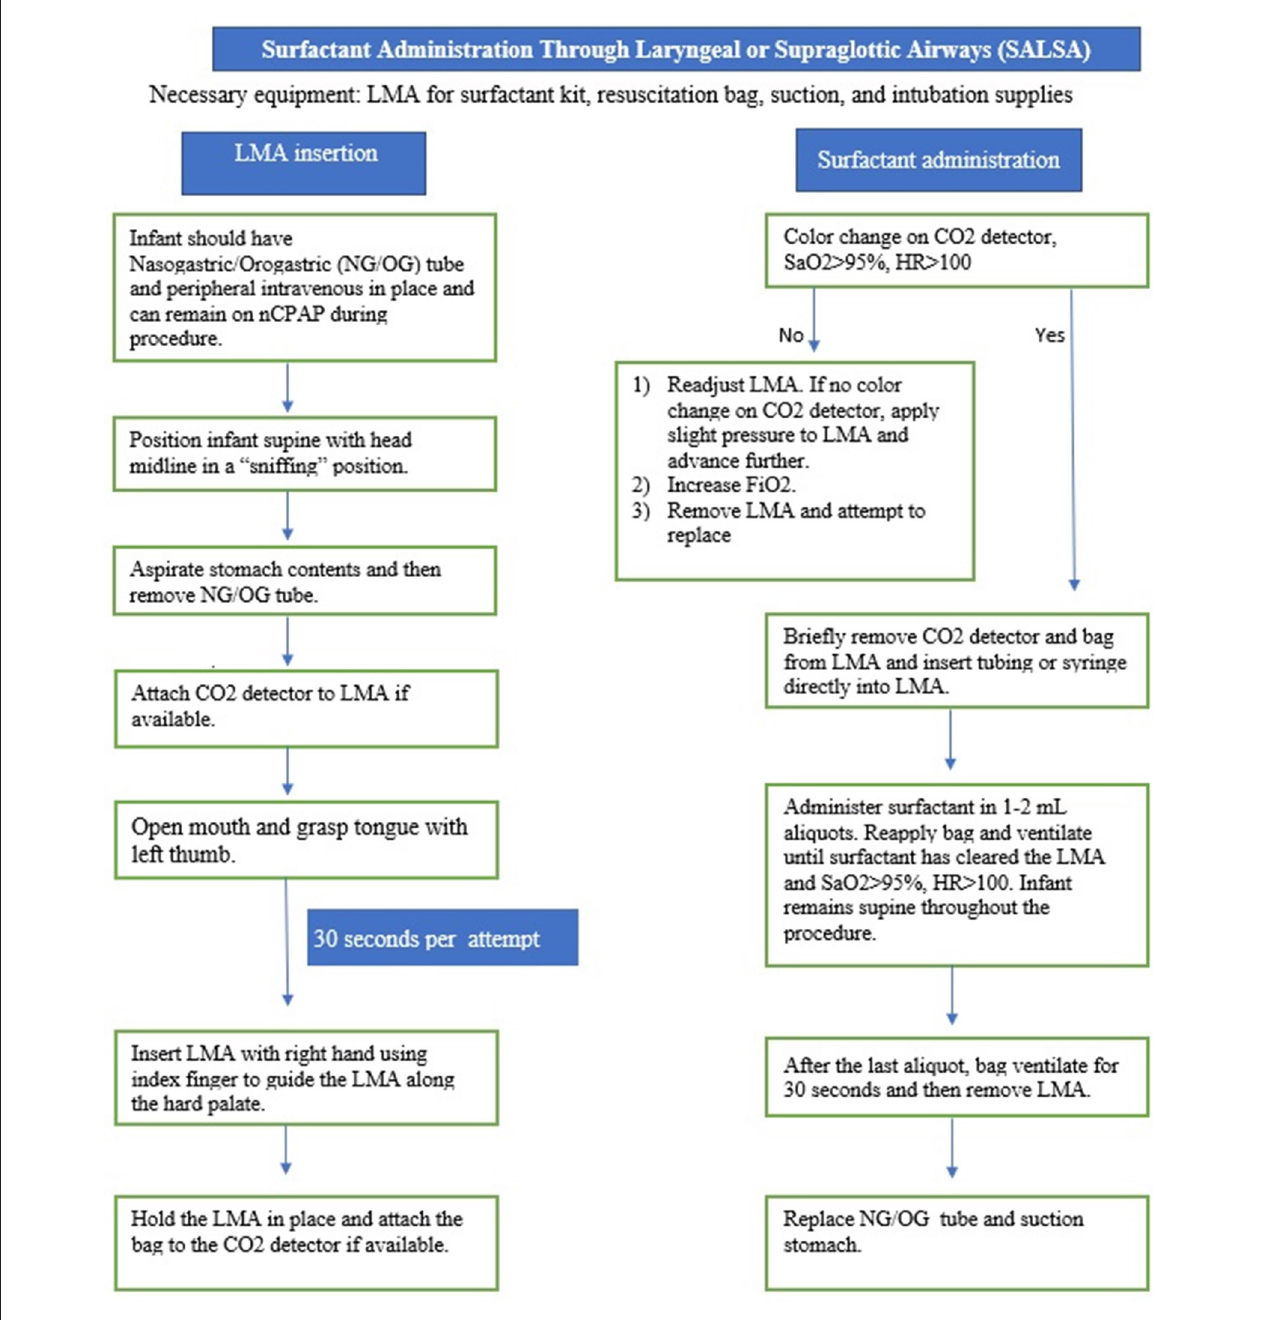
FIGURE 1 | SALSA: Step-by-step